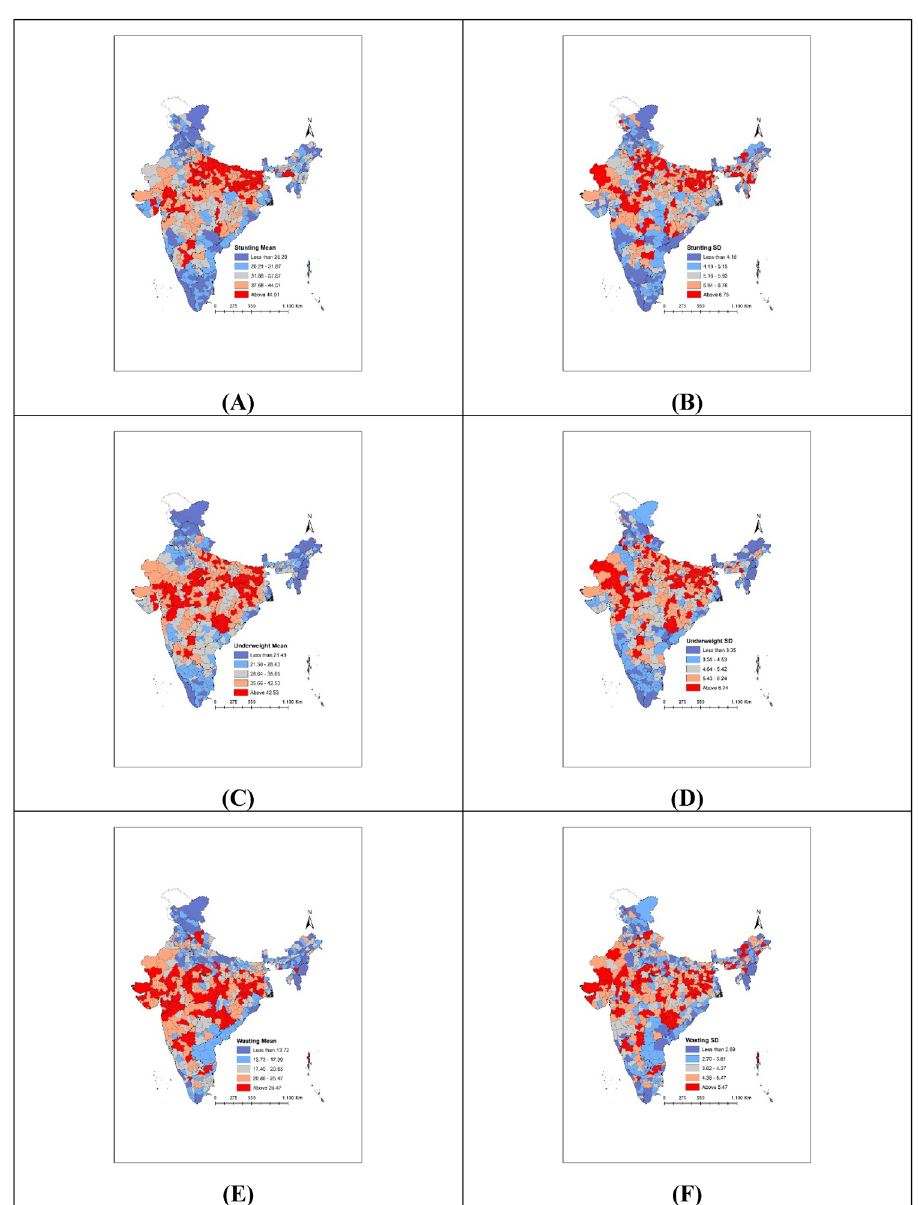
Figure 3. Maps showing geographic distribution of mean prevalence and SDs in child anthropometric failures across districts for ( A ) stunting—mean; ( B ) stunting—SD; ( C ) underweight—mean; ( D ) underweight—SD; ( E